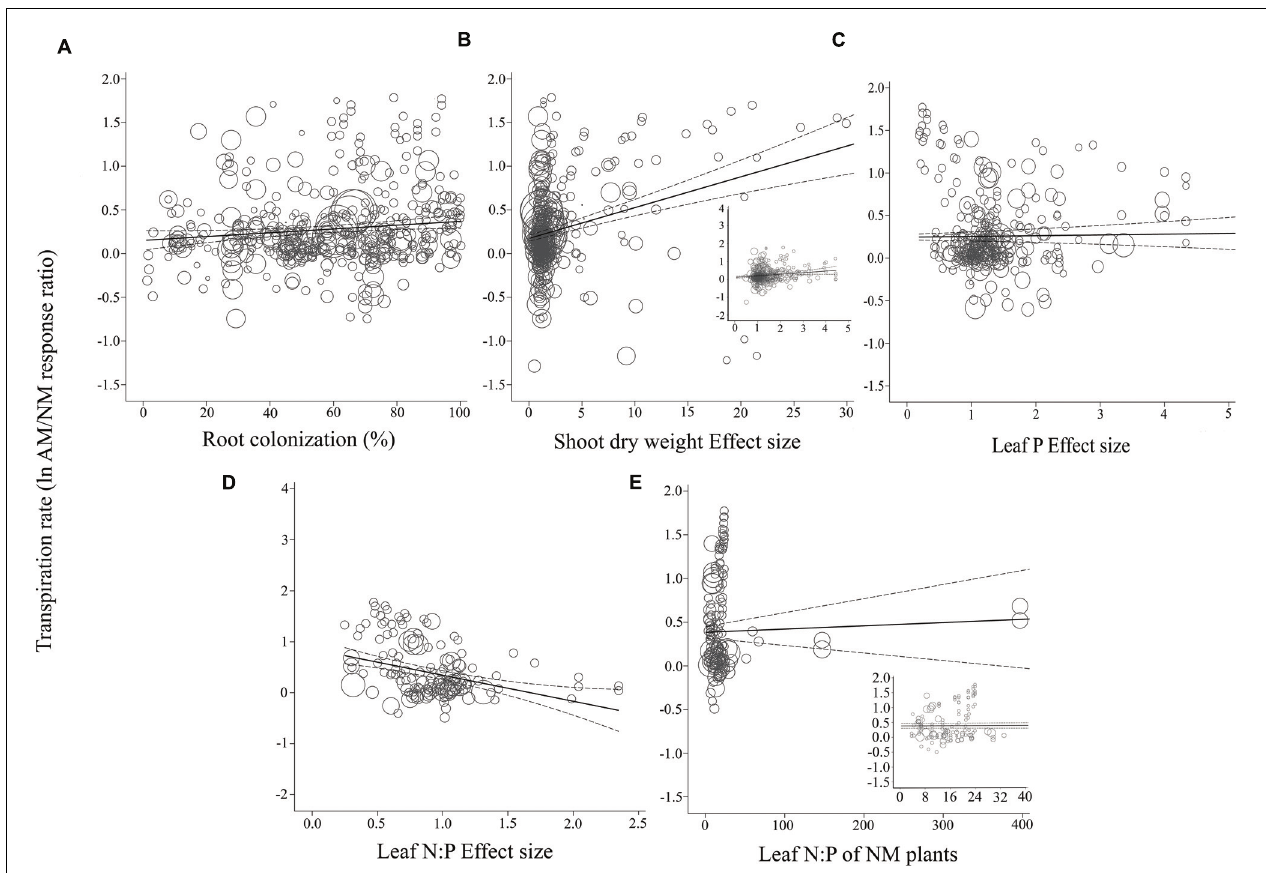
FIGURE 5 | Regression plots of the size of the AM-induced change in transpiration rate (ln R E ) as a function of (A) percent root colonization; (B) AM/NM shoot DW effect size; (C) AM/NM leaf P effect size; (D) AM/NM leaf N:P effect size; (E) leaf N:P of NM plants. Darker center line is the model prediction; lighter lines are 95% confidence intervals. Each symbol represents one study, with a symbol size indicating its weighting. Insets in (B) and (E) are expanded views of the range containing the majority of studies for those moderators.